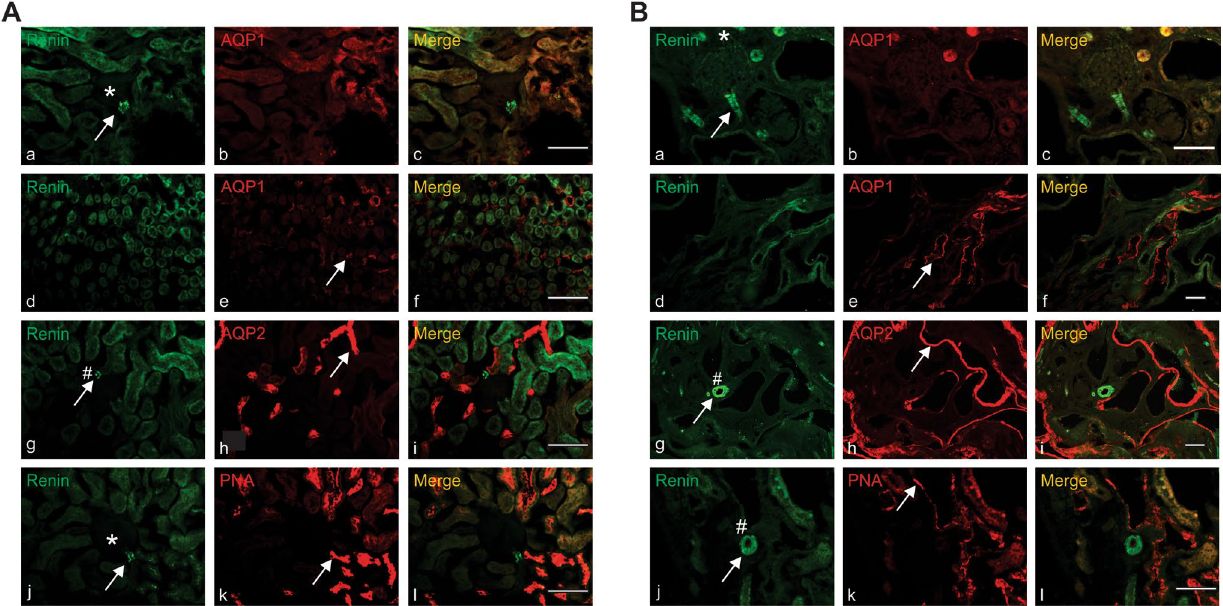
Figure 5. Representative images of double labelling of renin (a, d, g and j) and tubule segments marker AQP1 (b and e), AQP2 (h), PNA (k) in 7- or 10-weeks old Lewis ( A ) and LPK ( B ) rat kidney. Tubule segments marker AQP1 indicates the proximal tubule cells (b), AQP2 indicates the cortical and medullary collecting duct (e) and PNA indicates the distal tubule cells (h). Renin can be clearly seen in the juxtaglomerular apparatus (JGA, *indicates glomeruli) and blood vessels (#) clearly distinguishable from the low level autofluorescence in the renal tubules consistent with that previously described 58 . Arrows indicate positive staining and scale bar = 100 µm for all